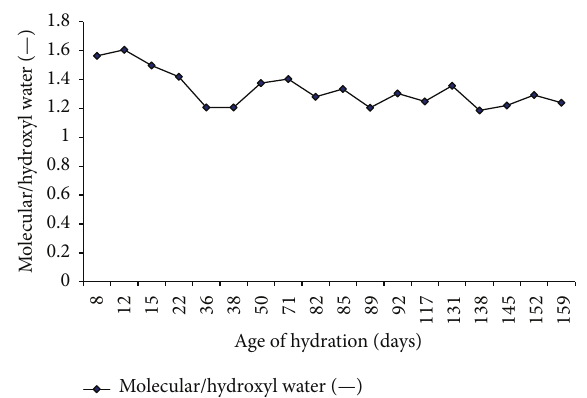
Figure 7: Molecular water to hydroxyl water ratio of hydrated ye’elimite clinker exposed to laboratory